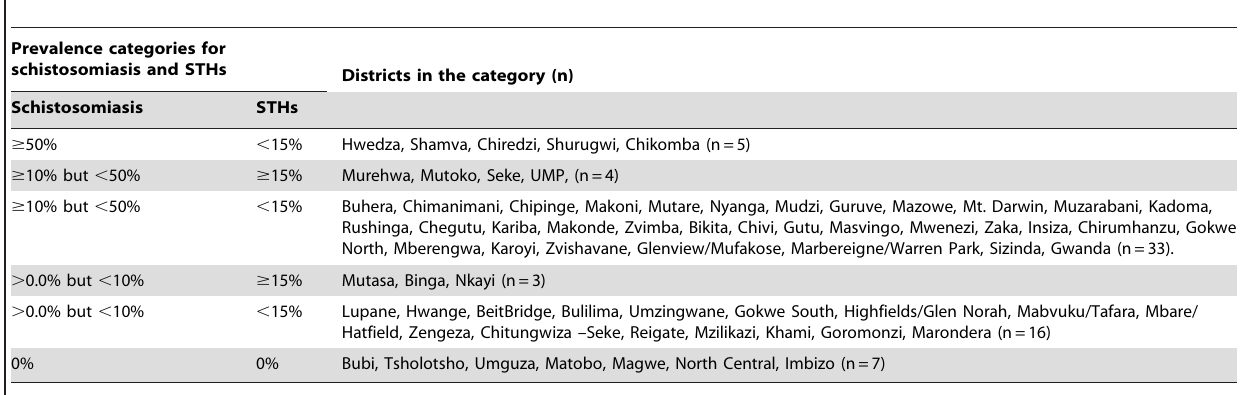
Table 6. Classification of 68 districts in Zimbabwe according to prevalence and overlap of schistosomiasis and STH in 2011.